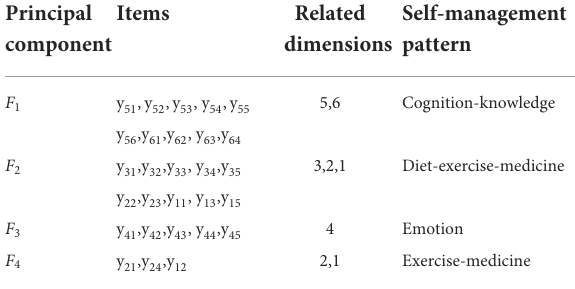
TABLE 6 Principal components, items, and